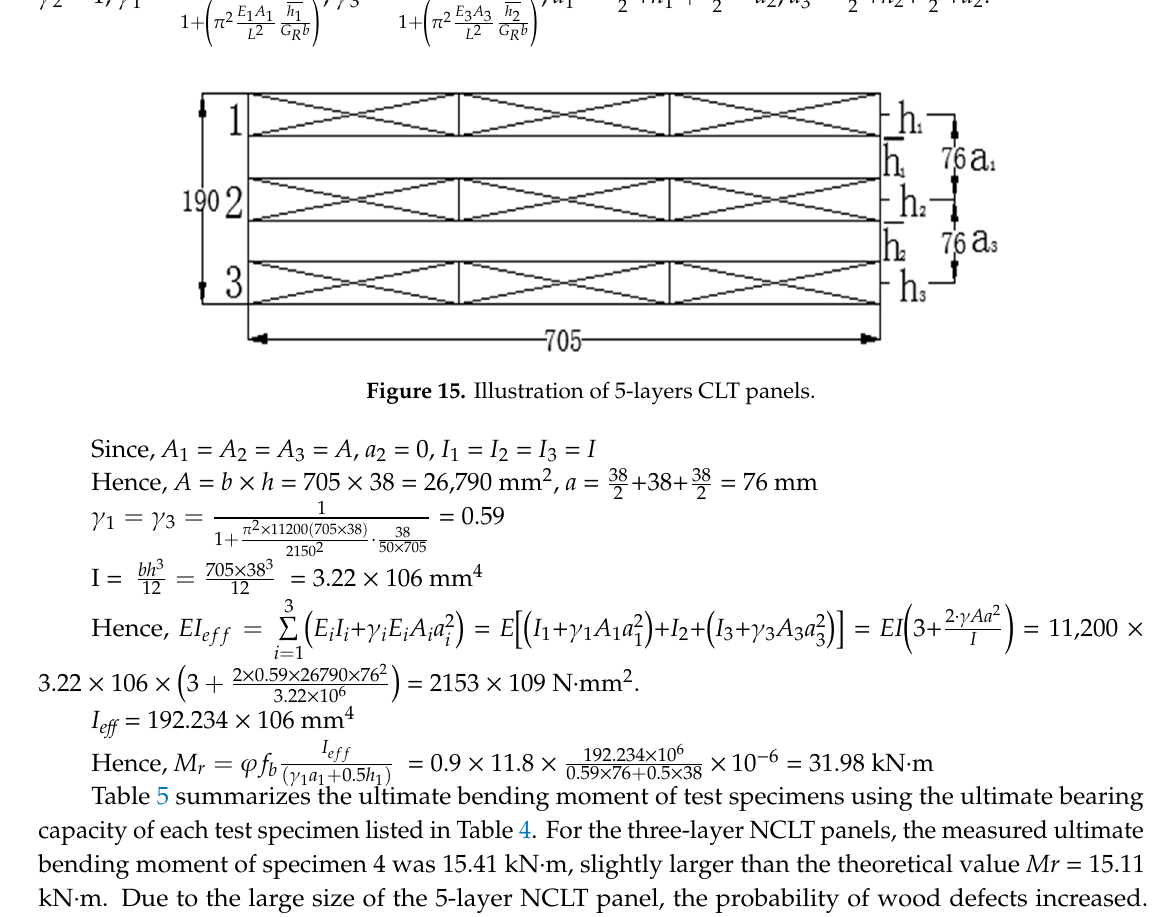
Table 5. Ultimate bending moment of all specimens.